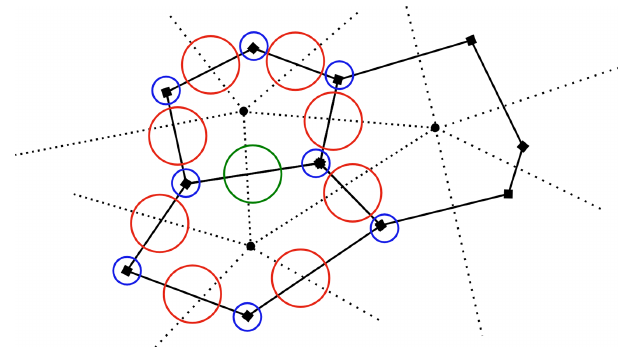
Figure 3. A diagram of the stencil of Q when applied to an edge e (green). The nonlinear PV flux Q F e at edge e (green) is a linear combination of the mass fluxes F e at the edges e (cid:48) ∈ ECP (e) (red), where the weights α e,e (cid:48) ,v are themselves a linear combination of the potential vorticity q v at vertices v ∈ VC (i) (blue), and i is the cell shared between edges e (green) and e (cid:48) (red). By choosing the weights α e,e (cid:48) ,v appropriately, an operator Q can be found that si- multaneously conserves both total energy and potential enstrophy and supports steady geostrophic